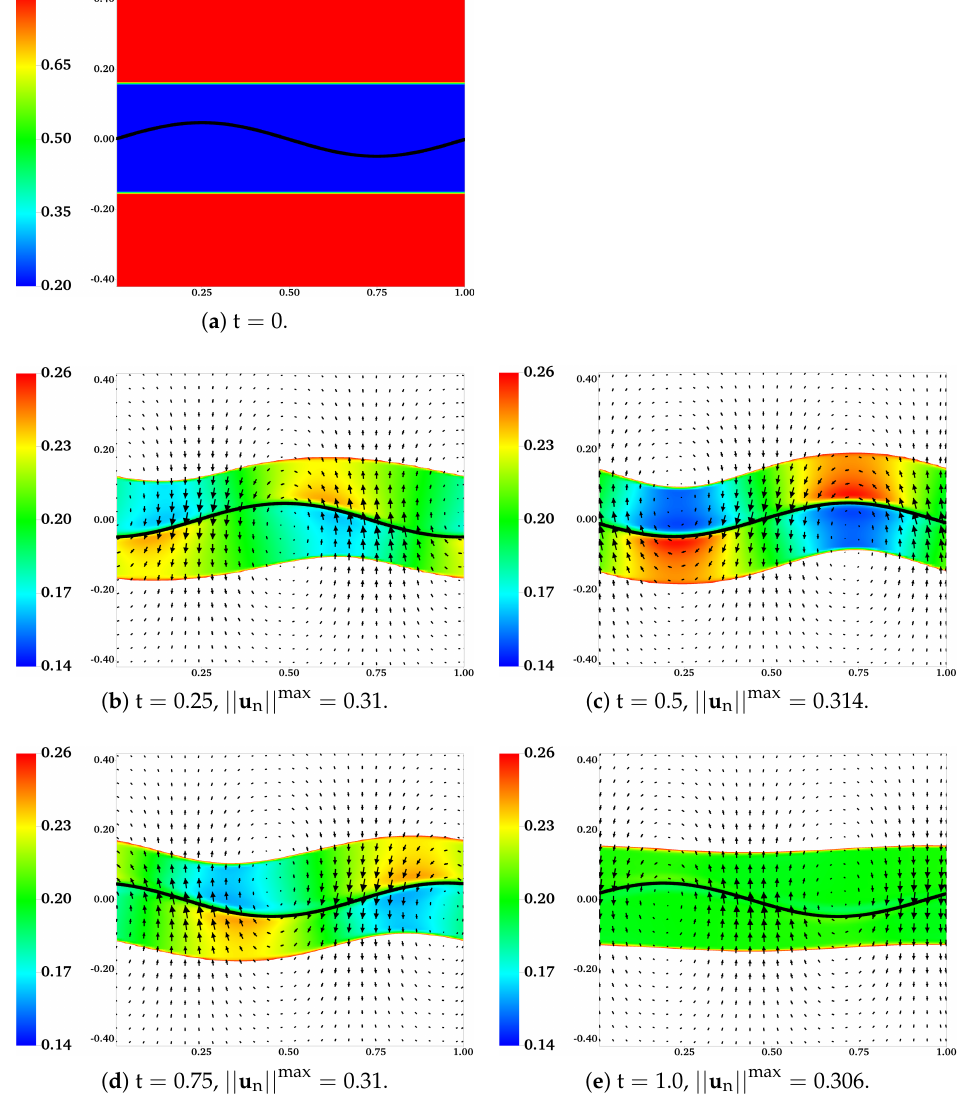
Figure 10. H = 0.16, β = 0.25, ξ = 100, θ i n n = 0.2, and θ o ut n = 0.8. Distributions of θ n and u n at different time. All vectors have the same